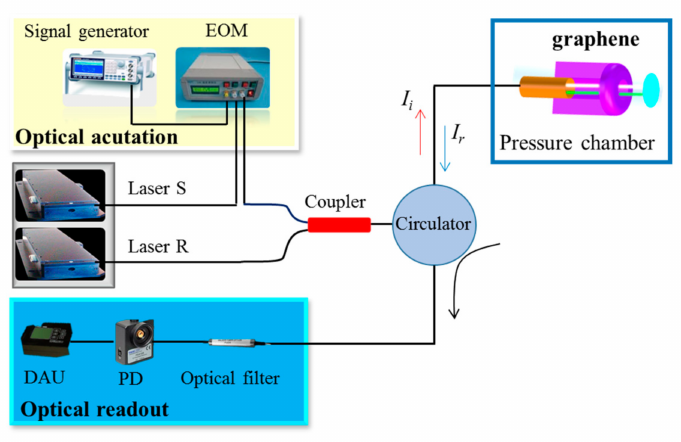
Figure 2. Schematic illustration of optical fiber F-P interferometry setup for resonance